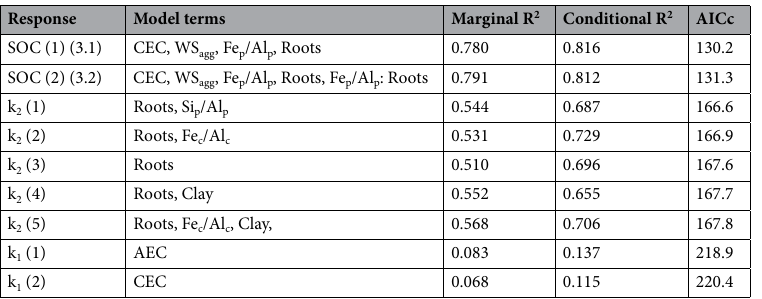
Table 3. Model selection results for SOC content, k 2 , and k 1 with associated marginal (fixed effect) R 2 , conditional (fixed and random effect) R 2 , and AICc. Models within 2 AICc points for each C response are